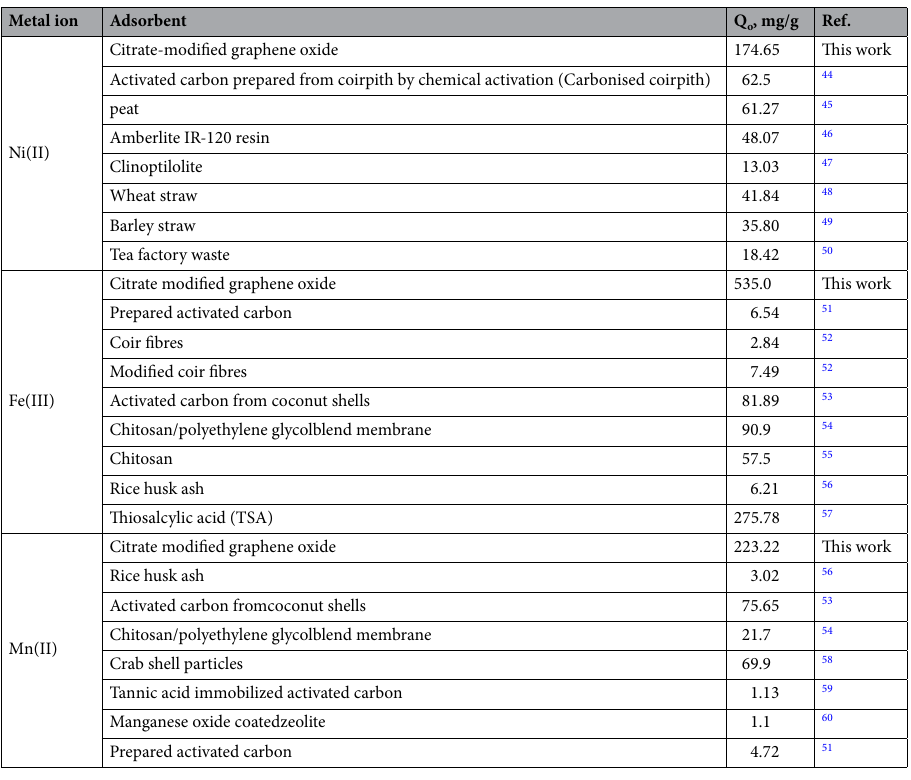
Table 5. Comparison of capacity values for the studied heavy metal ions adsorbed by various